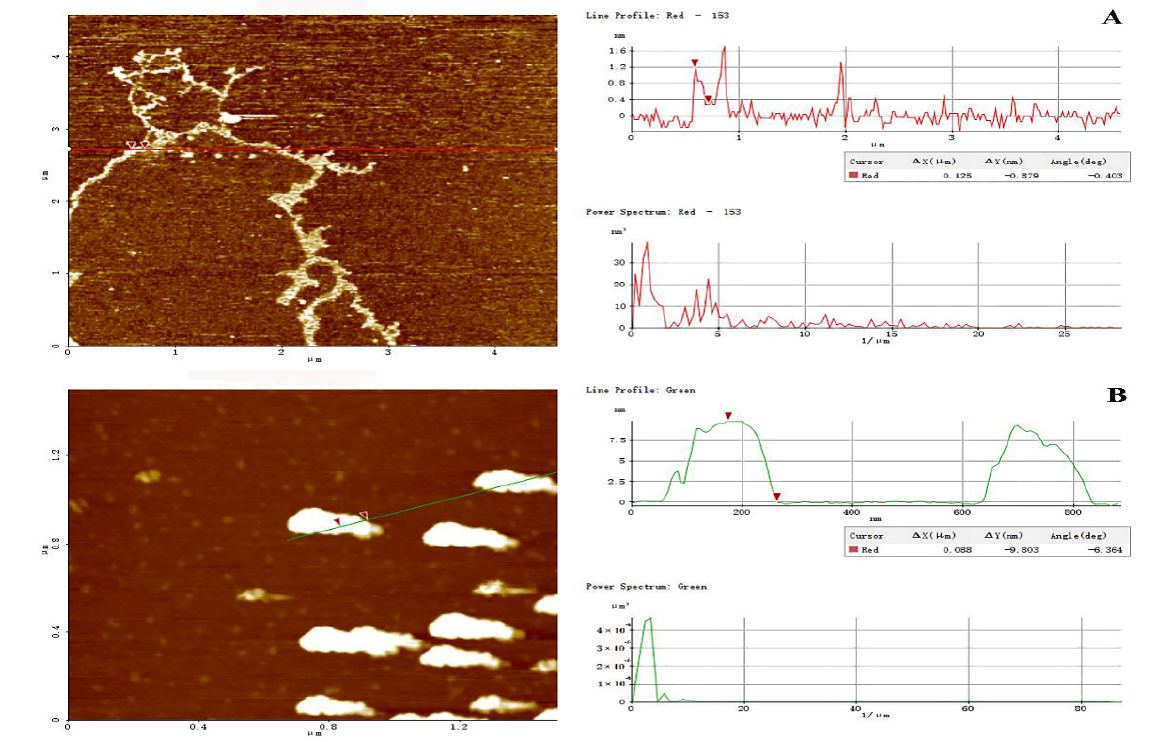
Figure 7. Tapping-mode AFM images of PHPS-D ( A ) and PHPS-W ( B ) at 10 µ g/mL on mica, with scan size of 5 µ m × 5 µ m. The cross-sectional profile is shown on the right side of each AFM image, and the curves with different colors in the cross-sectional profile correspond to the line of the same color in the AFM images on the left.